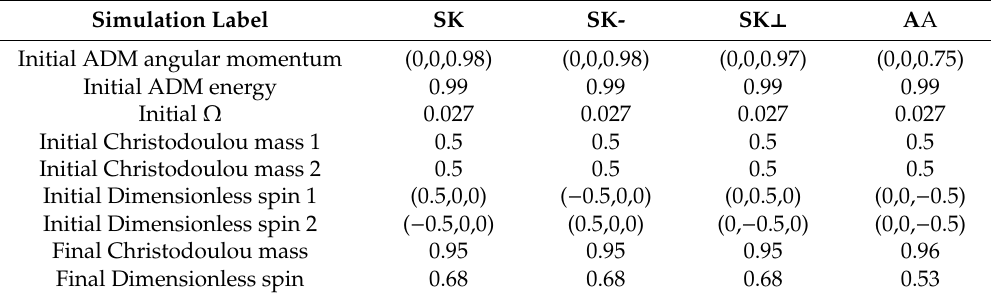
Table 1. Initial parameters for the binary black hole (BBH) simulations (these, and the times given in the figures of this paper, are in code units, or in other words, in arbitrary units; they scale with the total mass of the binary system according to their units). The symbol Ω refers to the initial angular frequency, computed with the Newtonian expression below Equation (5), using the initial total mass and separation of the black holes as inputs. In all the simulations, the black holes are initially on the x axis, and the orbital plane is spanned by the x and y axes, while the total angular momentum is in the ˆ z direction (the hat signifies unit magnitude). We also include the mass and spin of the final remnant black holes in the bottom two